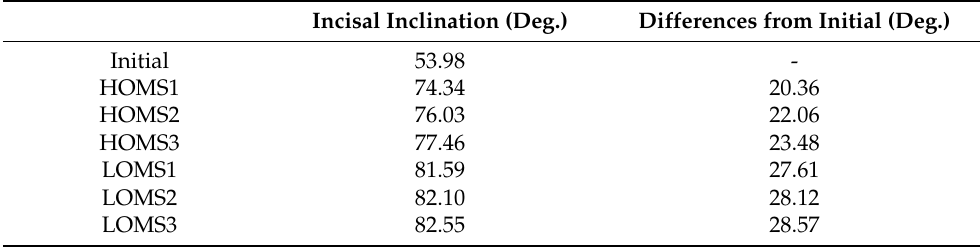
Table 5. Inclination of maxillary central incisor for each case. Incisal Inclination